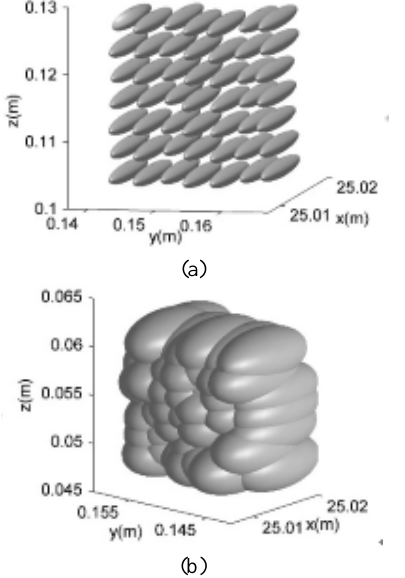
Figure 2. Point cloud error space:(a) the sampling interval d is equal to 5mm; (b) the sampling interval d is equal to 2mm.